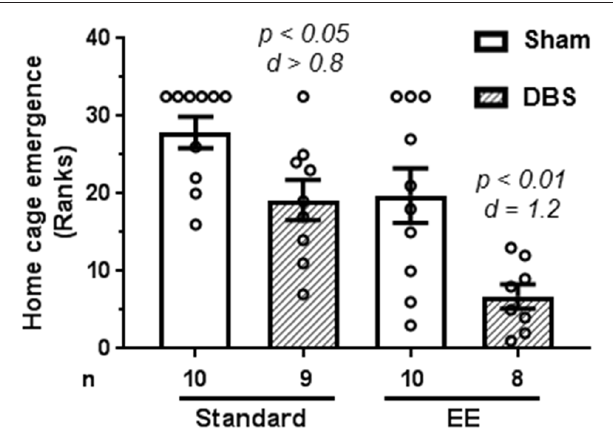
FIGURE 2 | Effects of DBS on anxiety in an elevated plus-maze in presence or absence of EE. Anxiety index was expressed as subtraction of open-arm exploration from 100. This endpoint was rank-transformed for the illustration. Mean and SEM, along with individual rank of animals in each group, are depicted. Number of animals ( n ) is also presented. Both p and Cohen’s d values are shown for statistically significant comparisons between DBS and corresponding sham